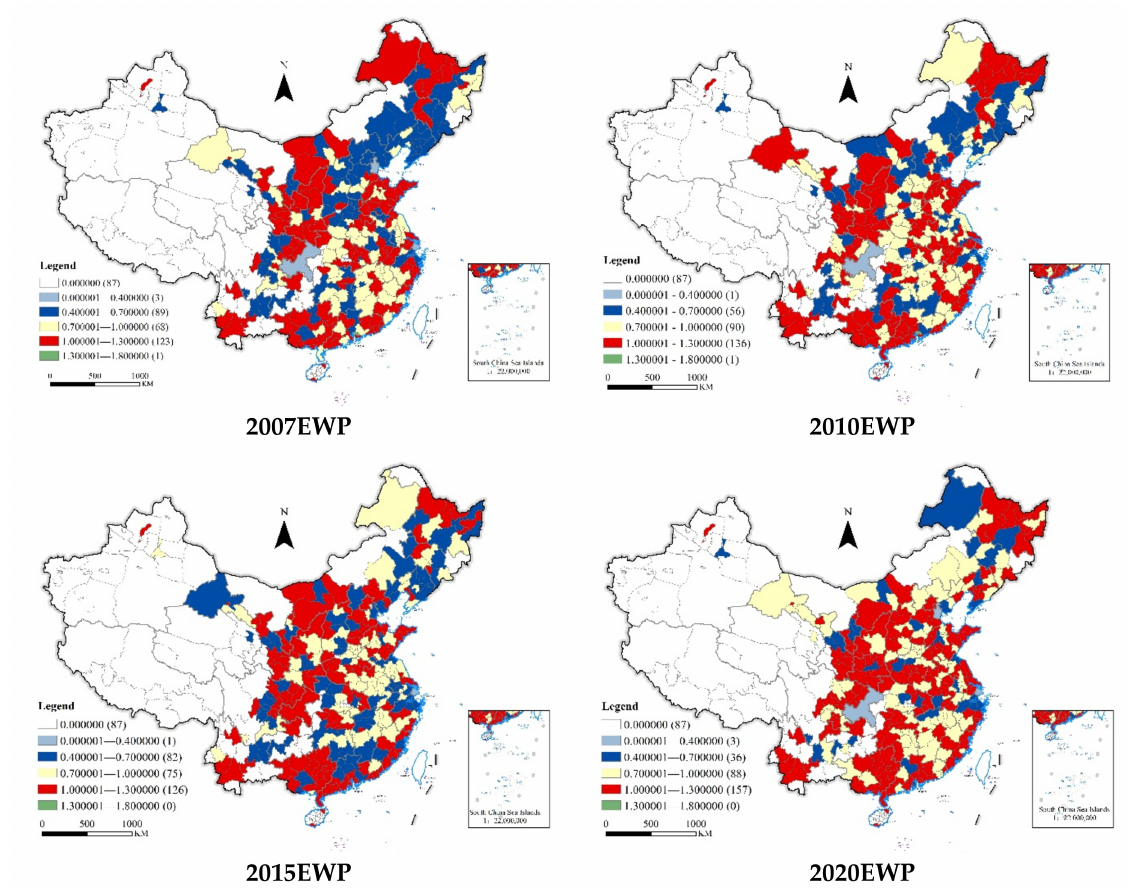
Figure 5. Spatial distribution characteristics of Chinese cities’ EWP from 2007 to 2020. Note: the map is drawn according to the Standard Map Service Website of the Ministry of natural resources (map review No. GS (2020)